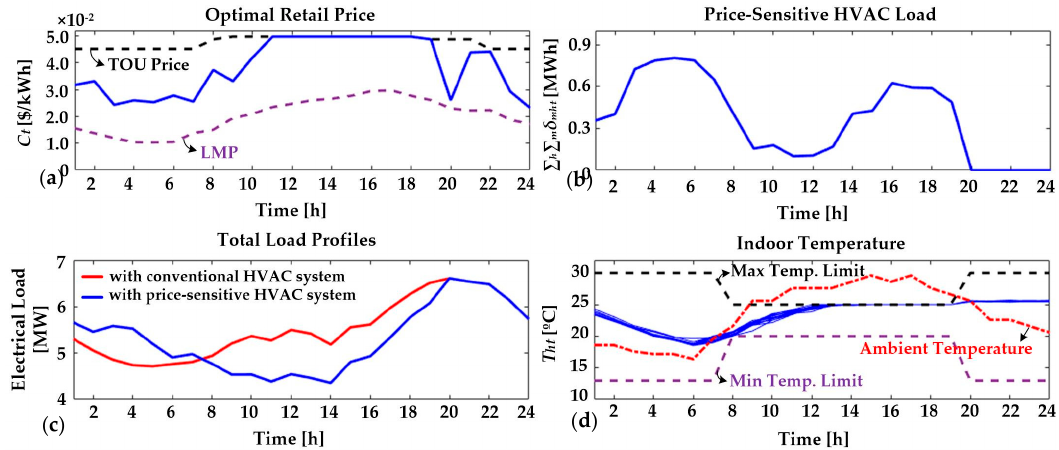
Figure 7. Optimal profiles for the proposed strategy considering peak load reduction with the duck curve: ( a ) the optimal retail price, ( b ) total input power of the price-elastic HVAC units, ( c ) total load profiles, and ( d ) indoor temperature variations in 15 building